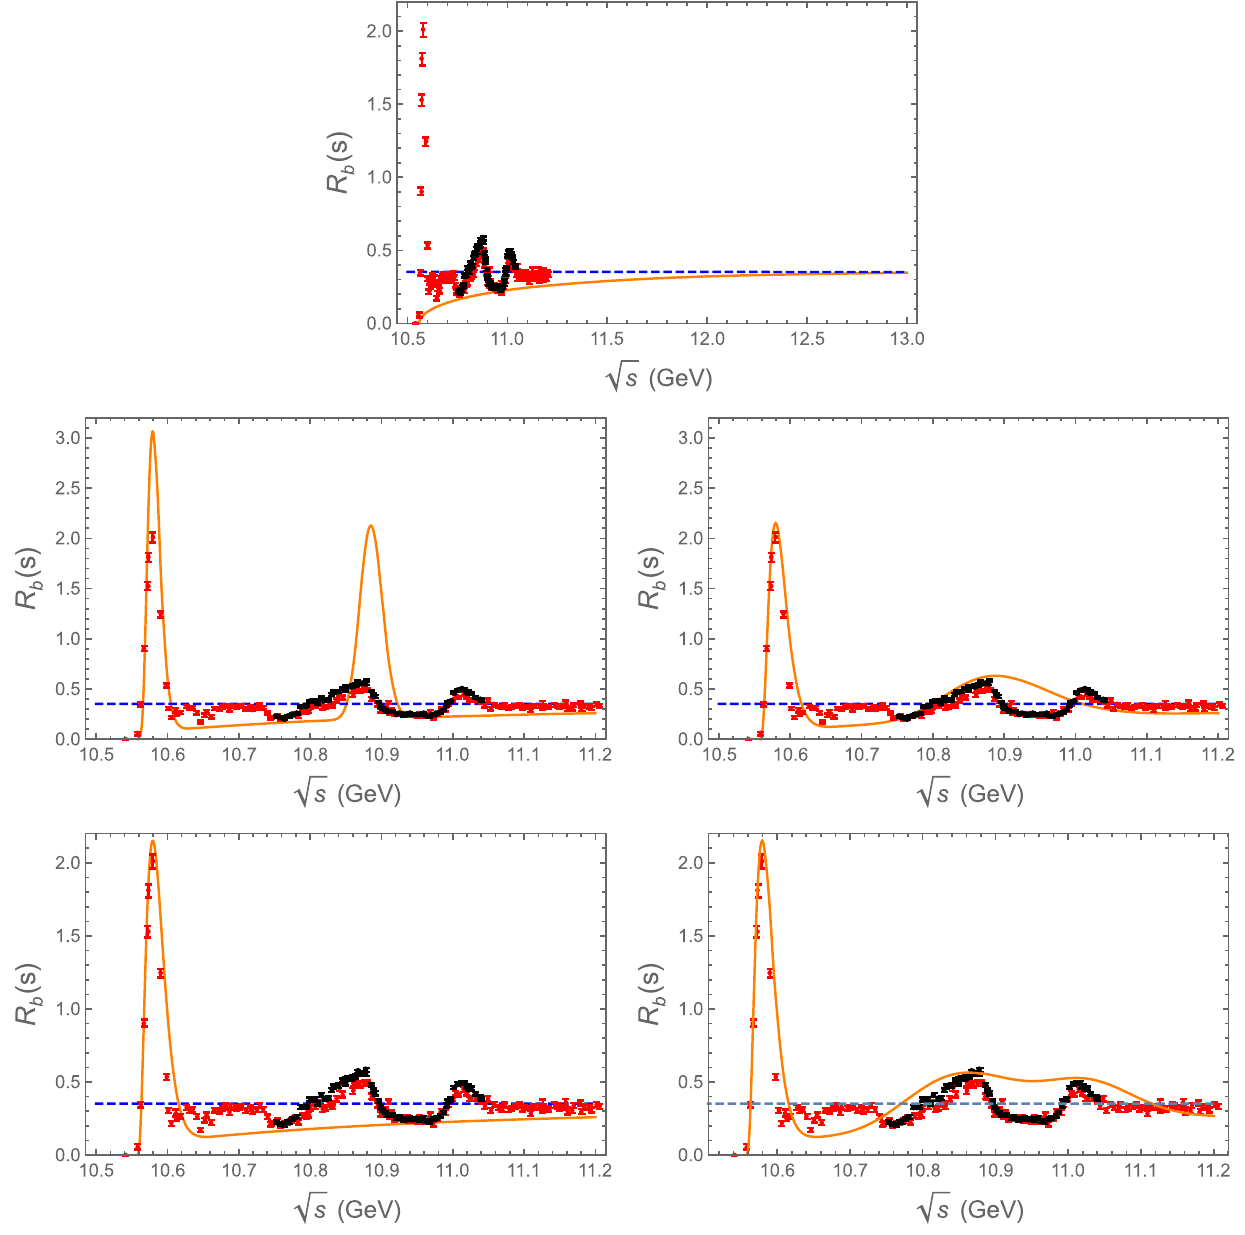
Fig. 2 R b ( s ) from ISR corrected BaBar [37] data (red points) and from Belle [38] data (black points) compared with different choices for our ansatz for continuum plus resonances. The blue dashed line is the pQCD prediction for R b ( s ) . Upper plot: Continuum ansatz without √ s = 13 GeV above the range where data are resonances extended up available. Middle row: Continuum ansatz including Gamma distribu- tions for the ϒ( 4 S ) and ϒ( 5 S ) resonances. In the left plot (our default